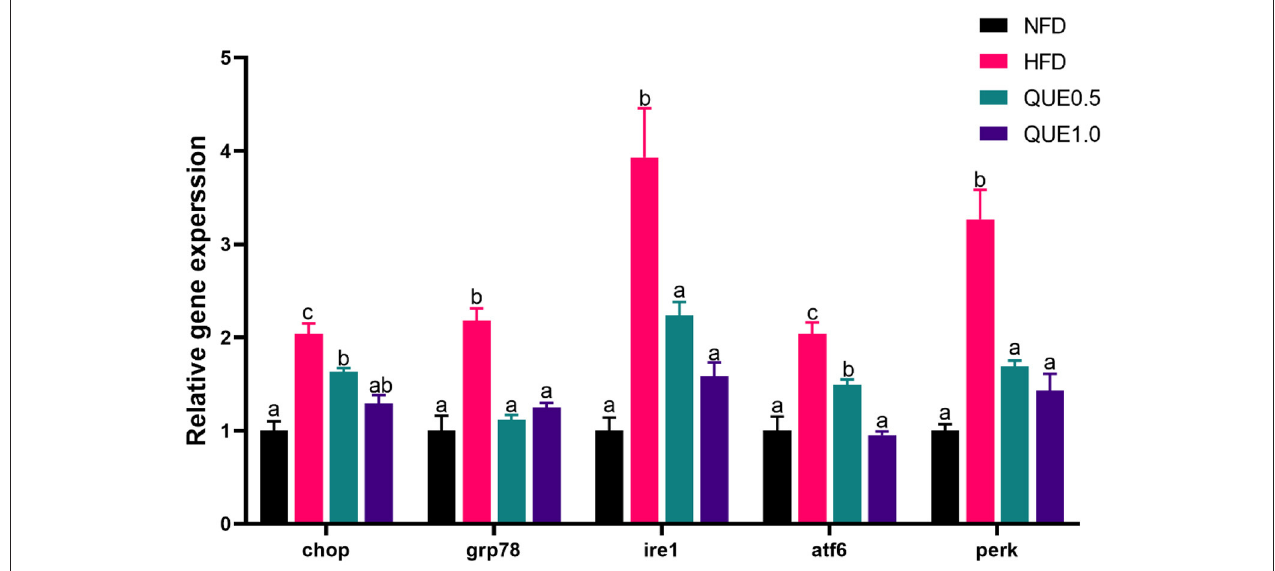
FIGURE 7 | The expressions of ERS-related genes in the liver of fish fed with experimental diets. ERS, endoplasmic reticulum stress. Different letters indicate a significant difference among groups ( P <